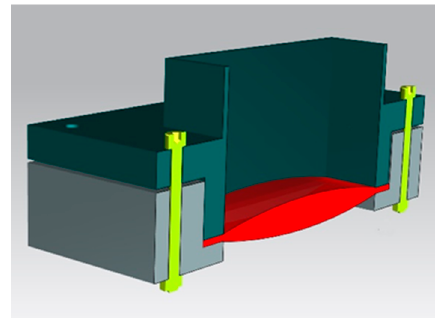
Figure 4. Rendered graphical representation of the f holder (in green and grey) used to fix the filter (in red) during the filtration process.